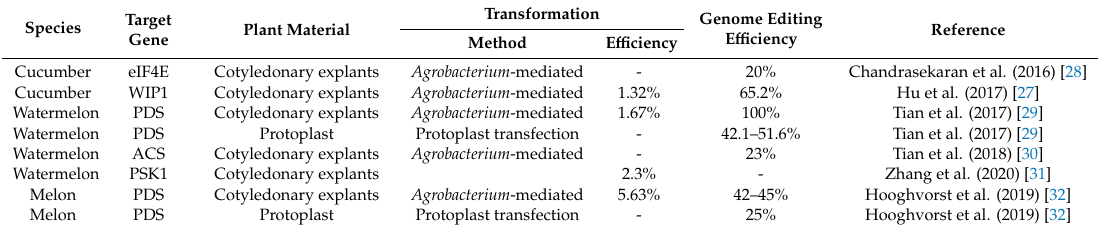
Table 2. Summary of the methodology and e ffi ciencies of CRISPR / Cas9 reported experiments in cucurbit